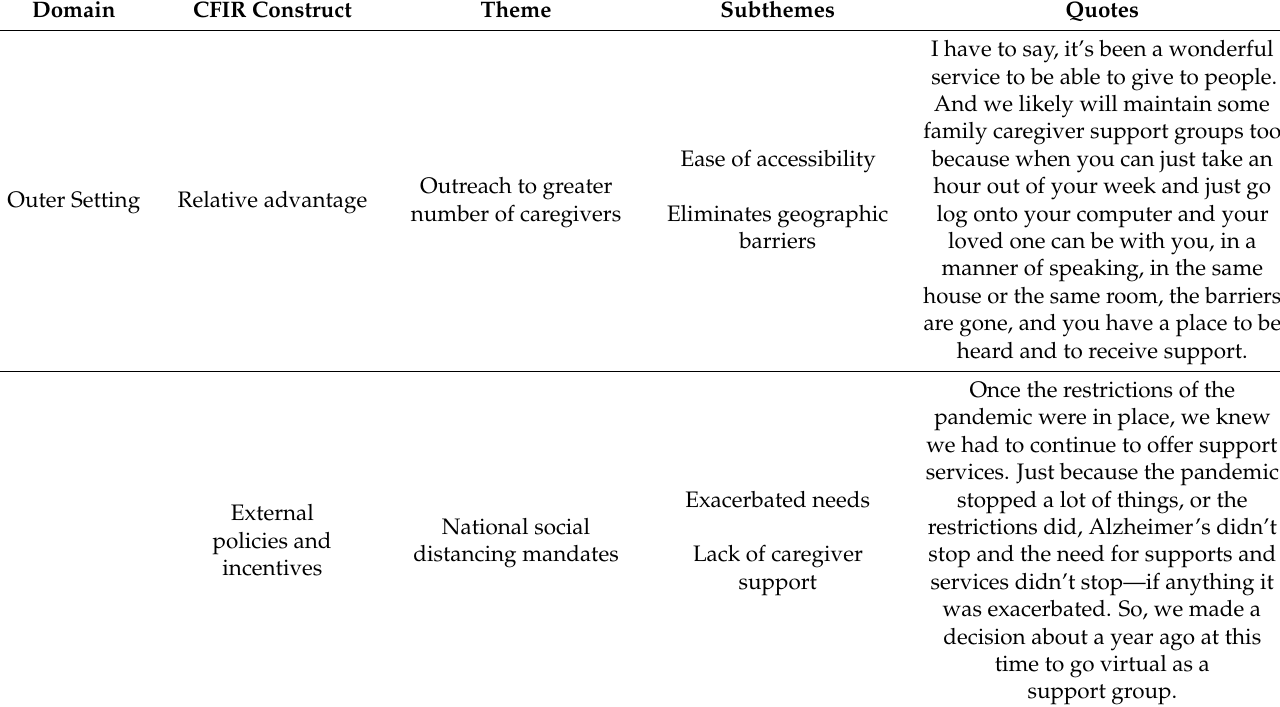
Table 3. Qualitative facilitator themes within CFIR domains and constructs—Alzheimer’s Tennessee.